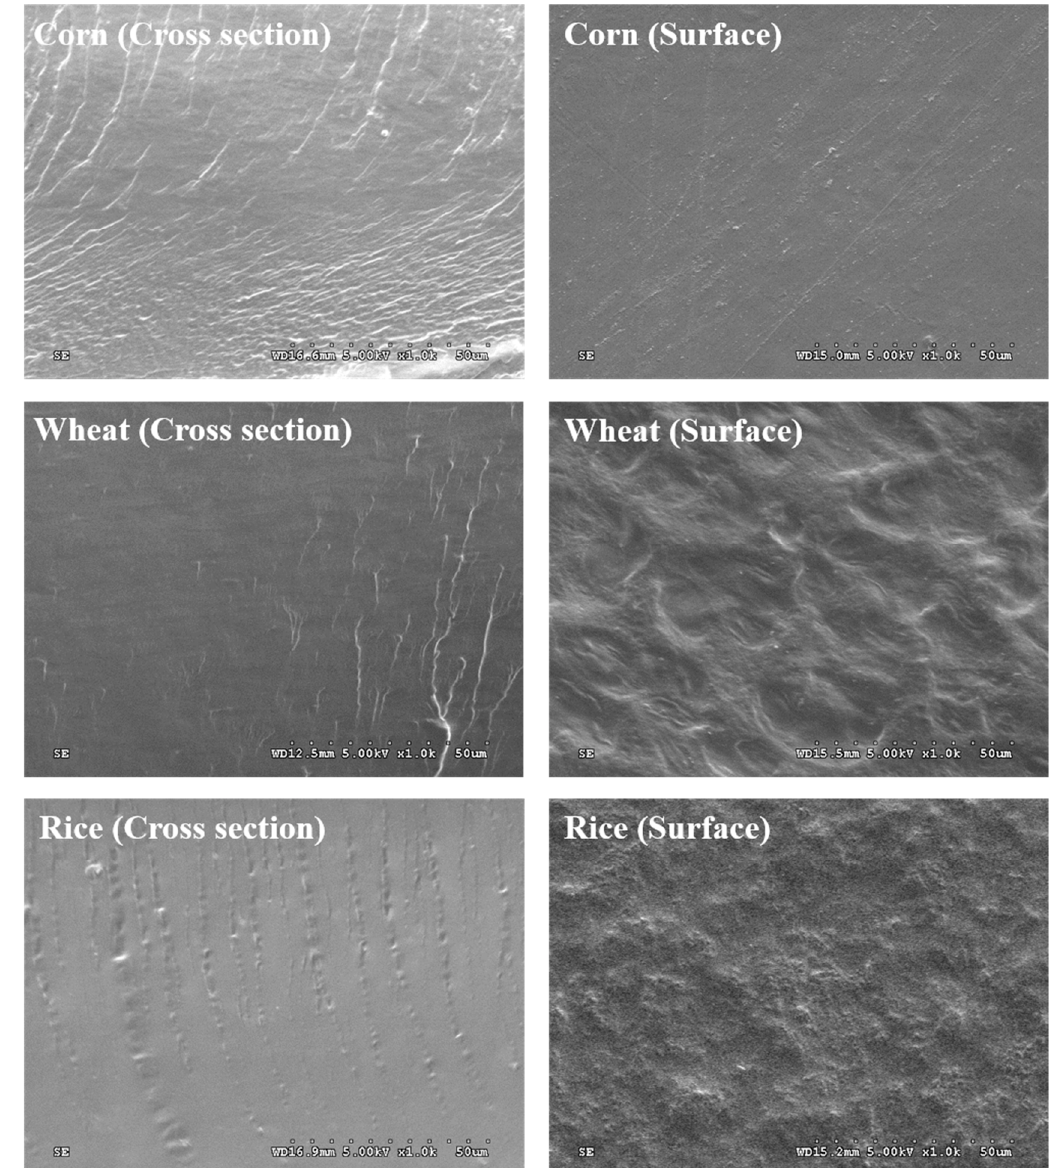
Figure 4. SEM micrographs of the cross sections and surfaces of potato, corn, wheat and rice starch films (Magnification 1,000×).